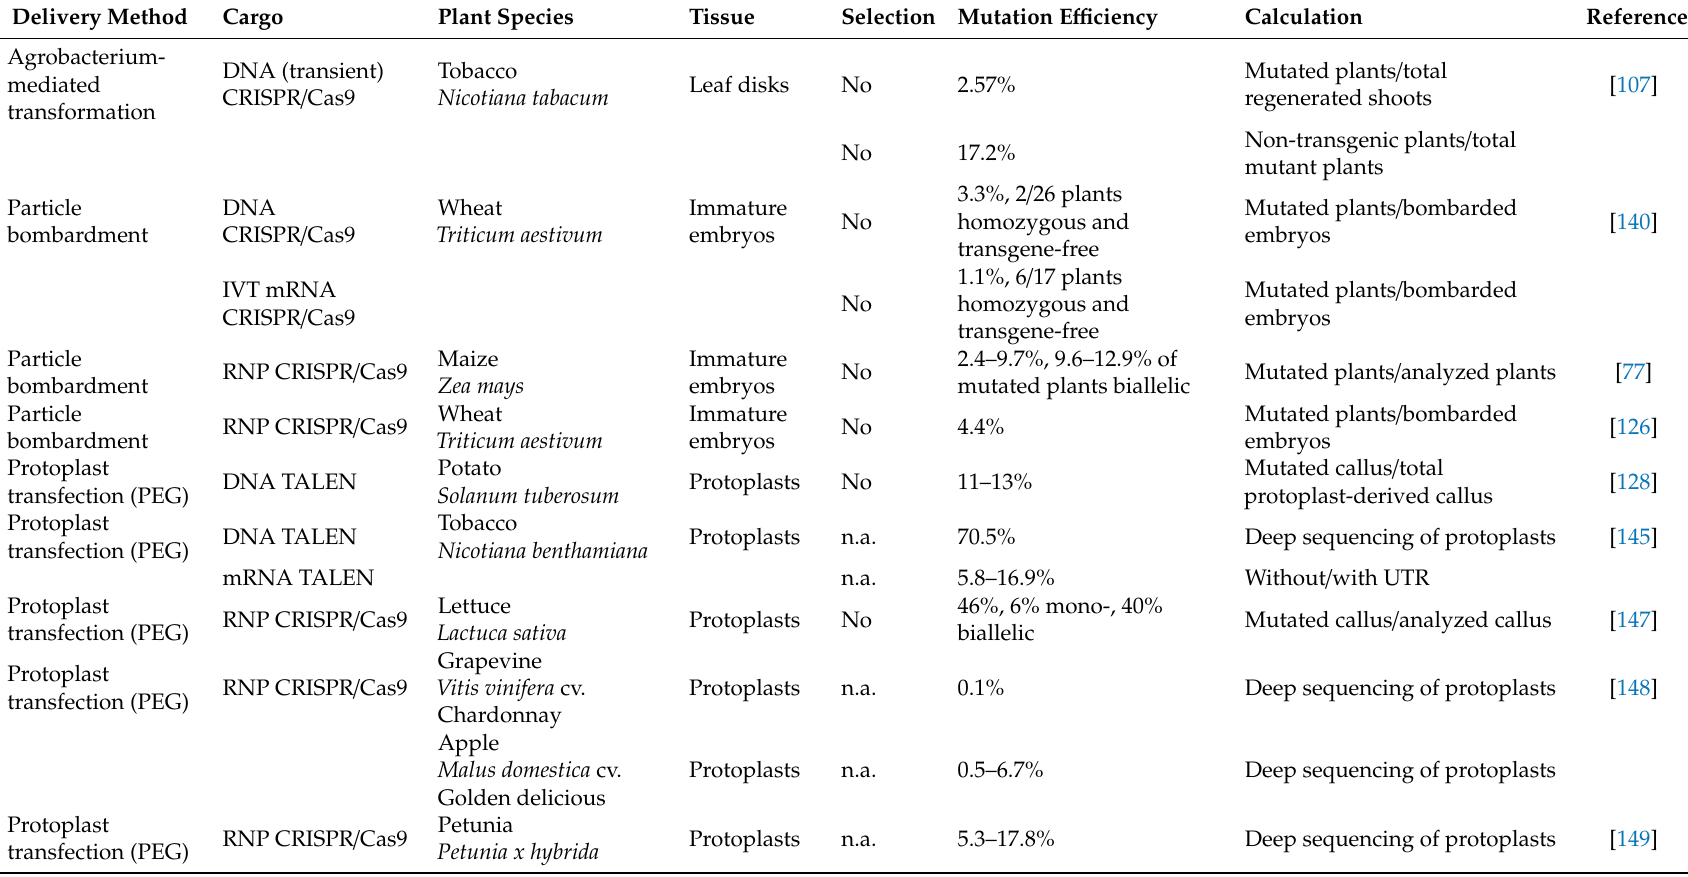
Table 1. Examples of selection-free genome editing in di ff erent plant